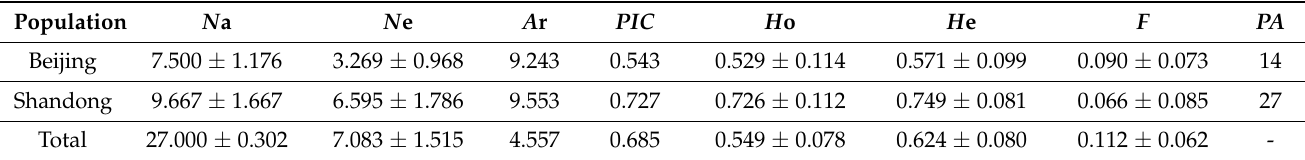
Table 2. Genetic diversity of Bombina orientalis populations based on microsatellite markers.